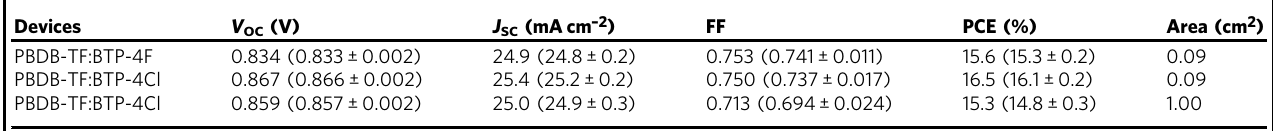
Table 1 Detailed photovoltaic parameters of the OPV cells